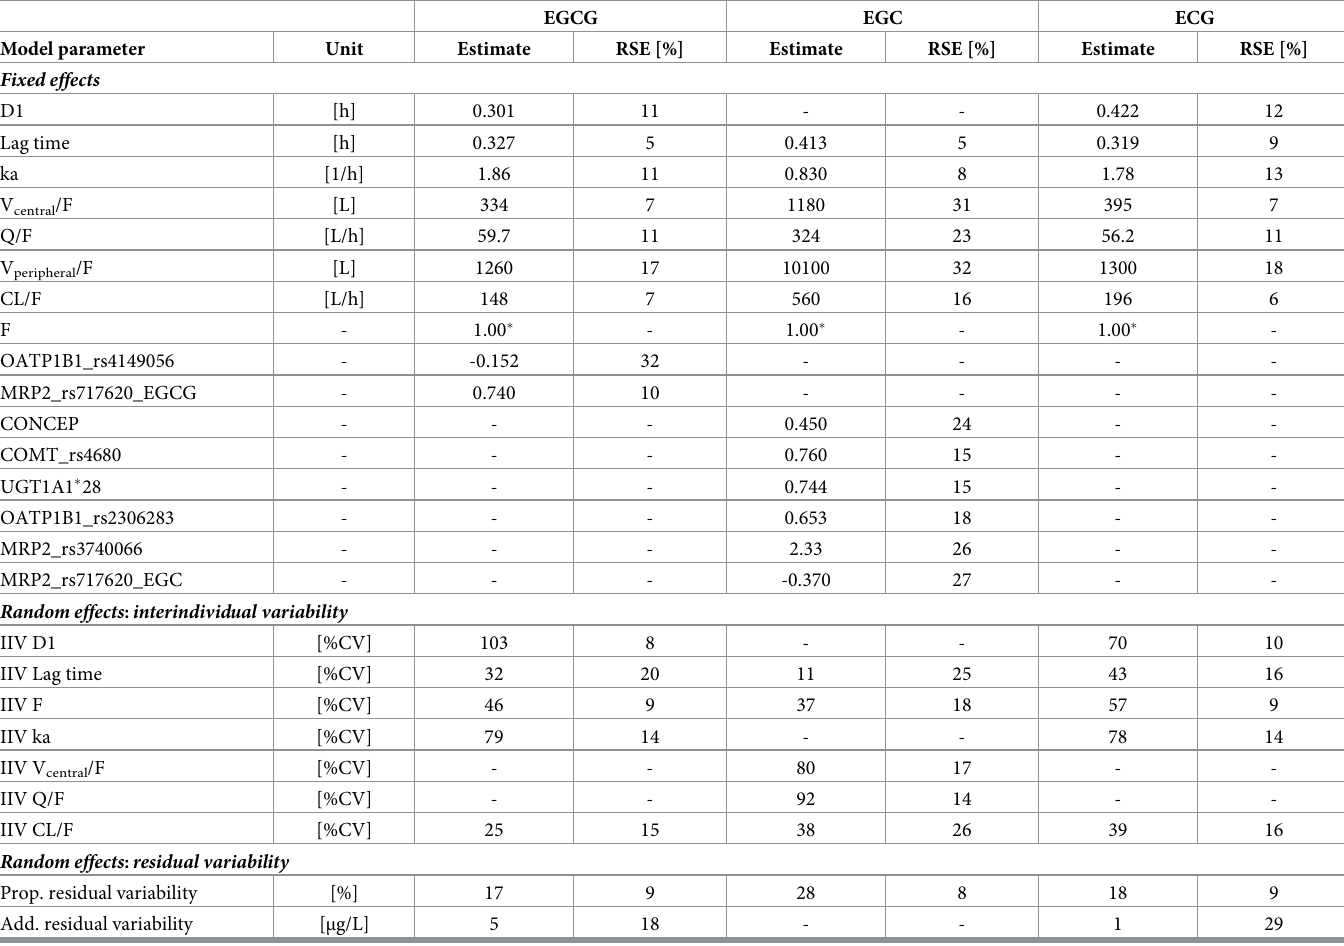
Table 3. Pharmacokinetic parameters, estimated with the final two-compartment